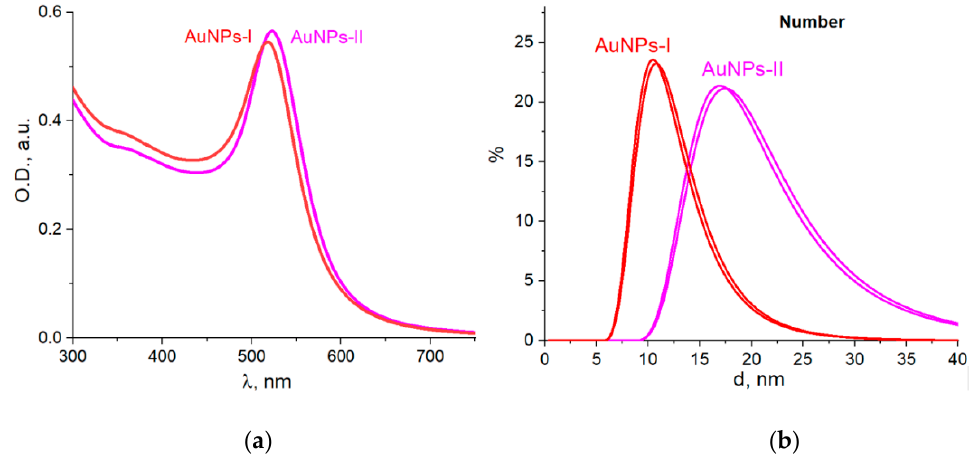
Figure 1. Absorption spectra ( a ) and DLS size distribution ( b ) of gold nanoparticles in obtained